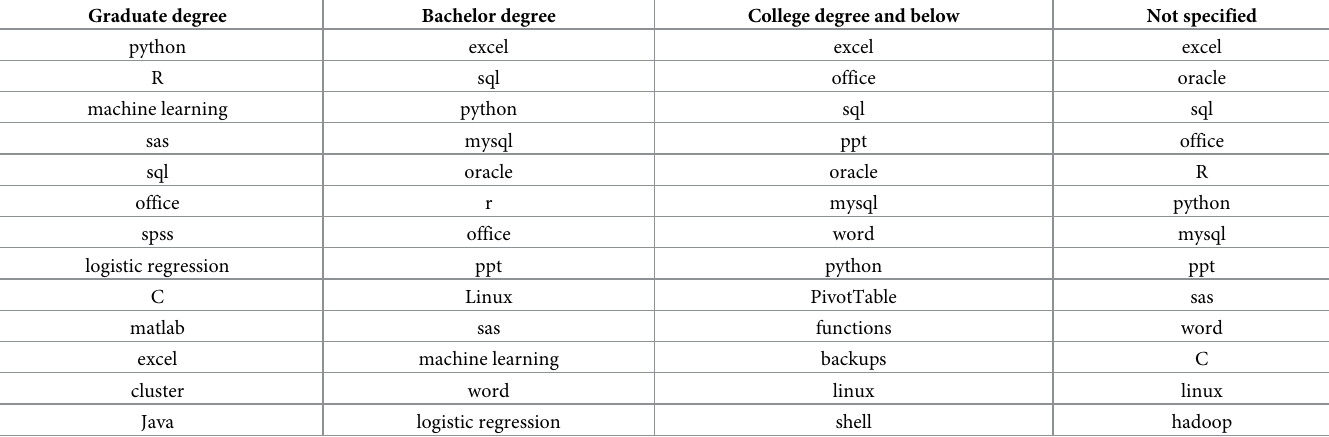
Table 5. Requirement of professional skill terms of each educational